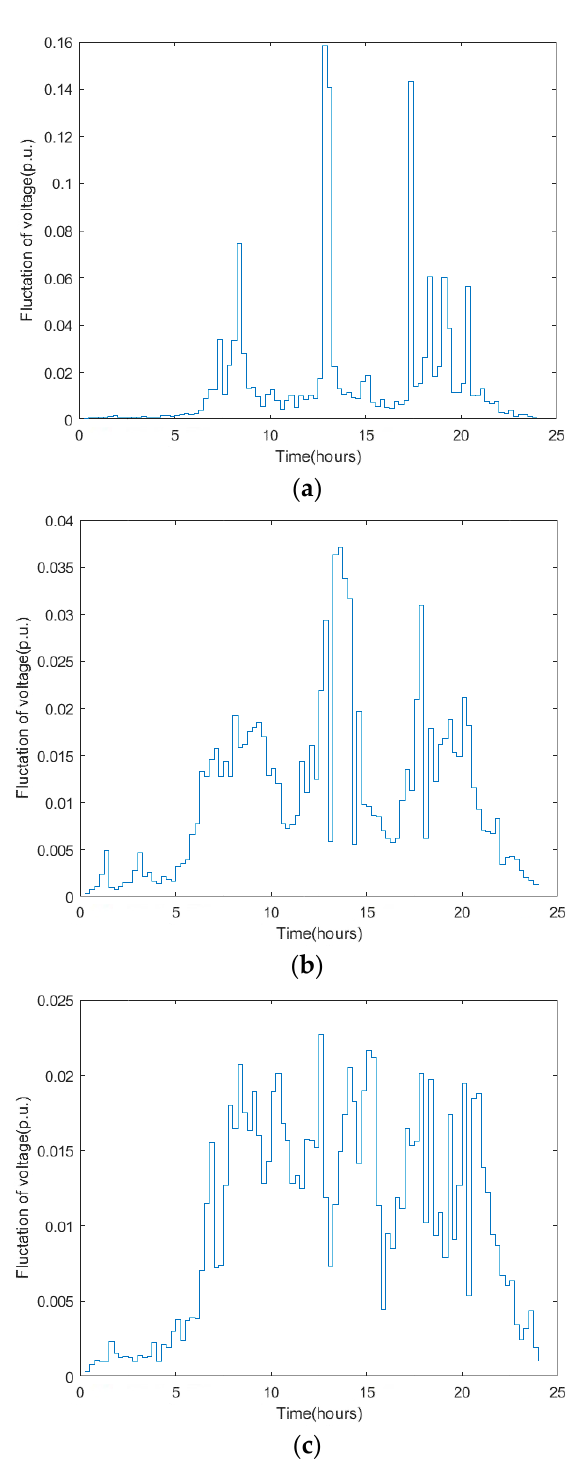
Figure 10. ( a ) Fluctuation index under disorderly charging strategy. ( b ) Fluctuation index under non-preferred charging strategy. ( c ) Fluctuation index under collaborative optimization strategy.